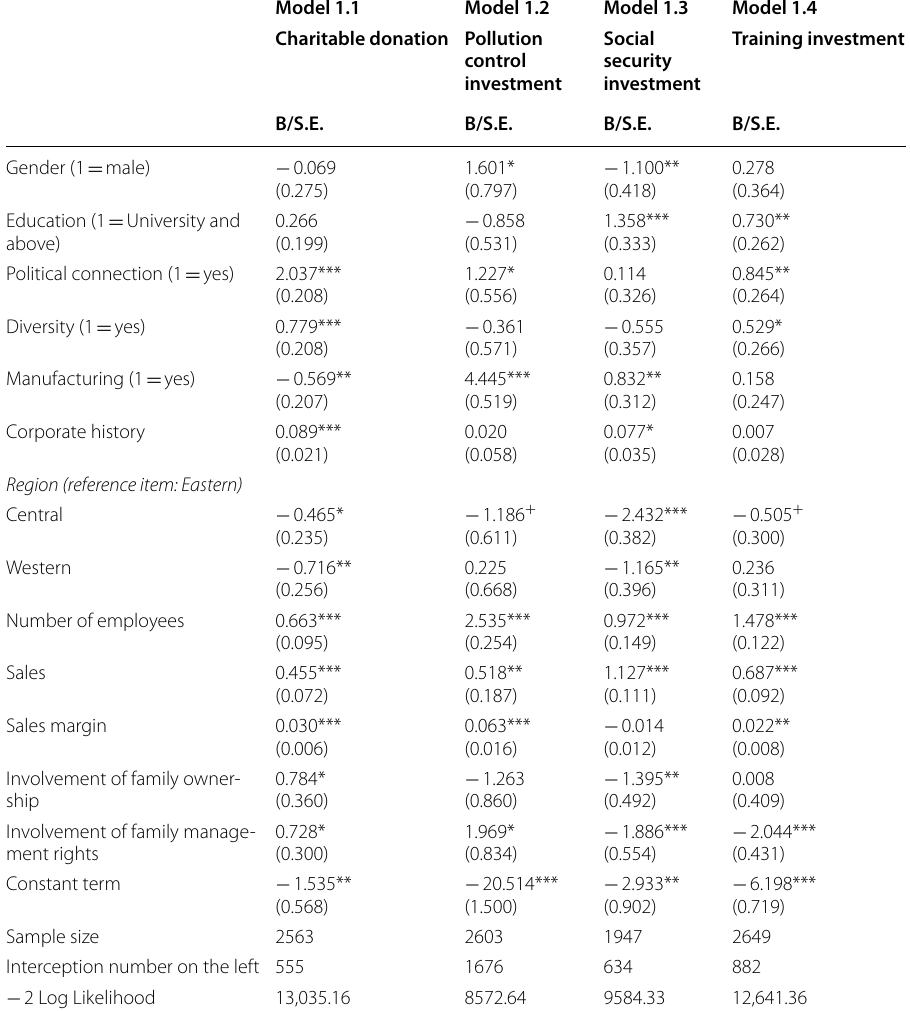
Table 2 Maximum likelihood estimation of the absolute amount of family involvement and CSR